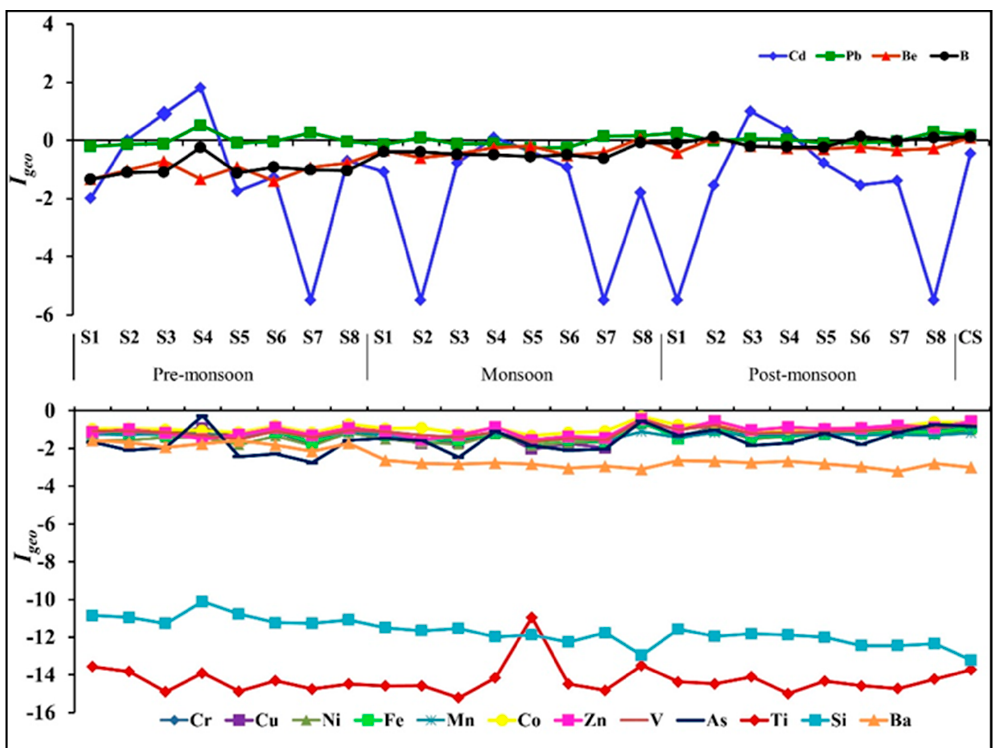
Figure 4. Geoaccumulation index ( I geo ) of individual trace elements from sampling sites along Hooghly River Estuary (HRE).